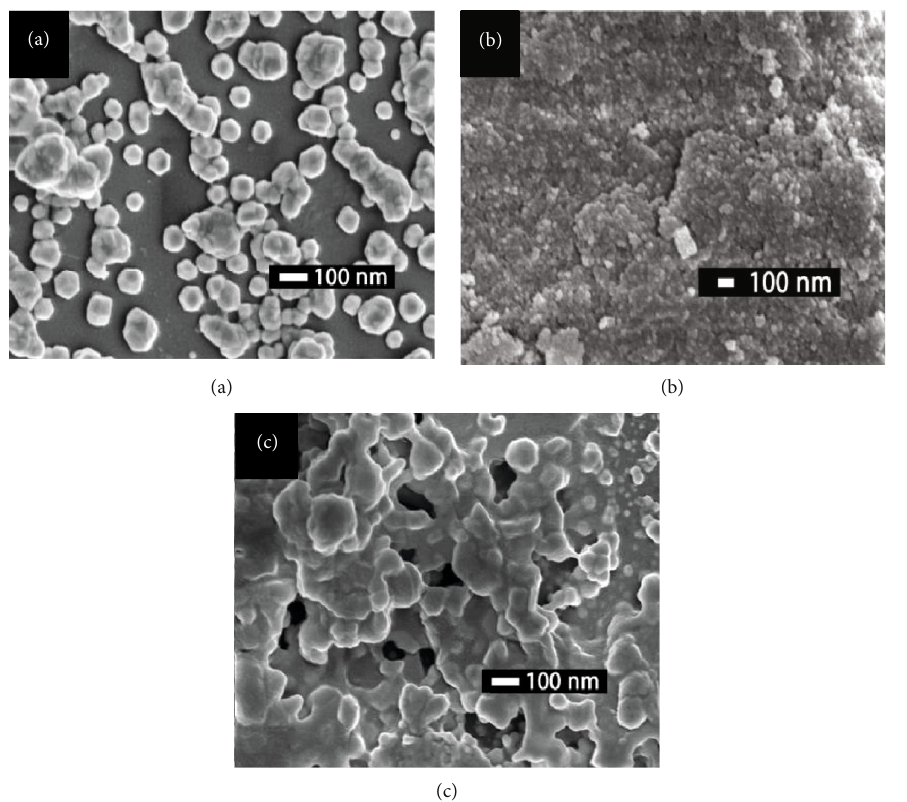
Figure 1: FE-SEM images of (a) pristine CeO